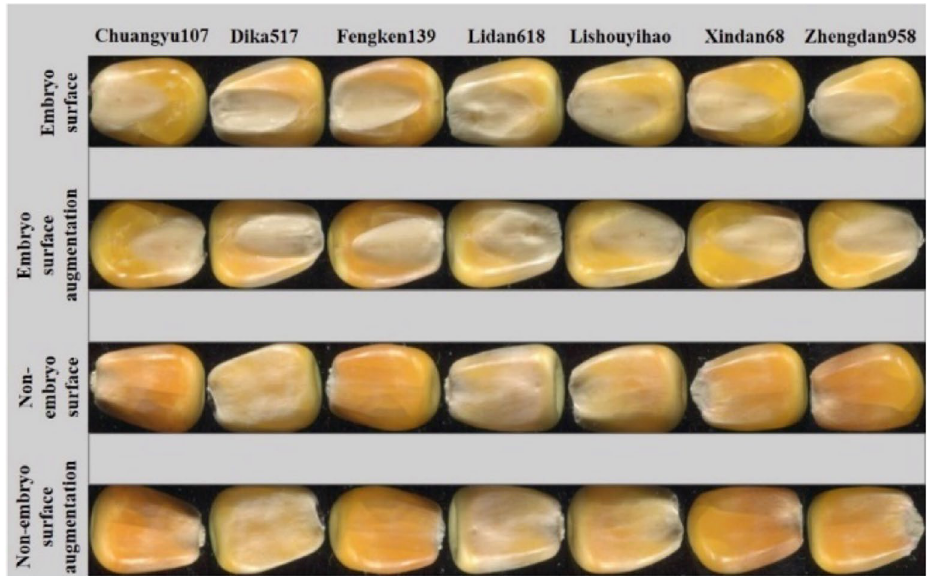
Figure 13. Model applicability test sample.